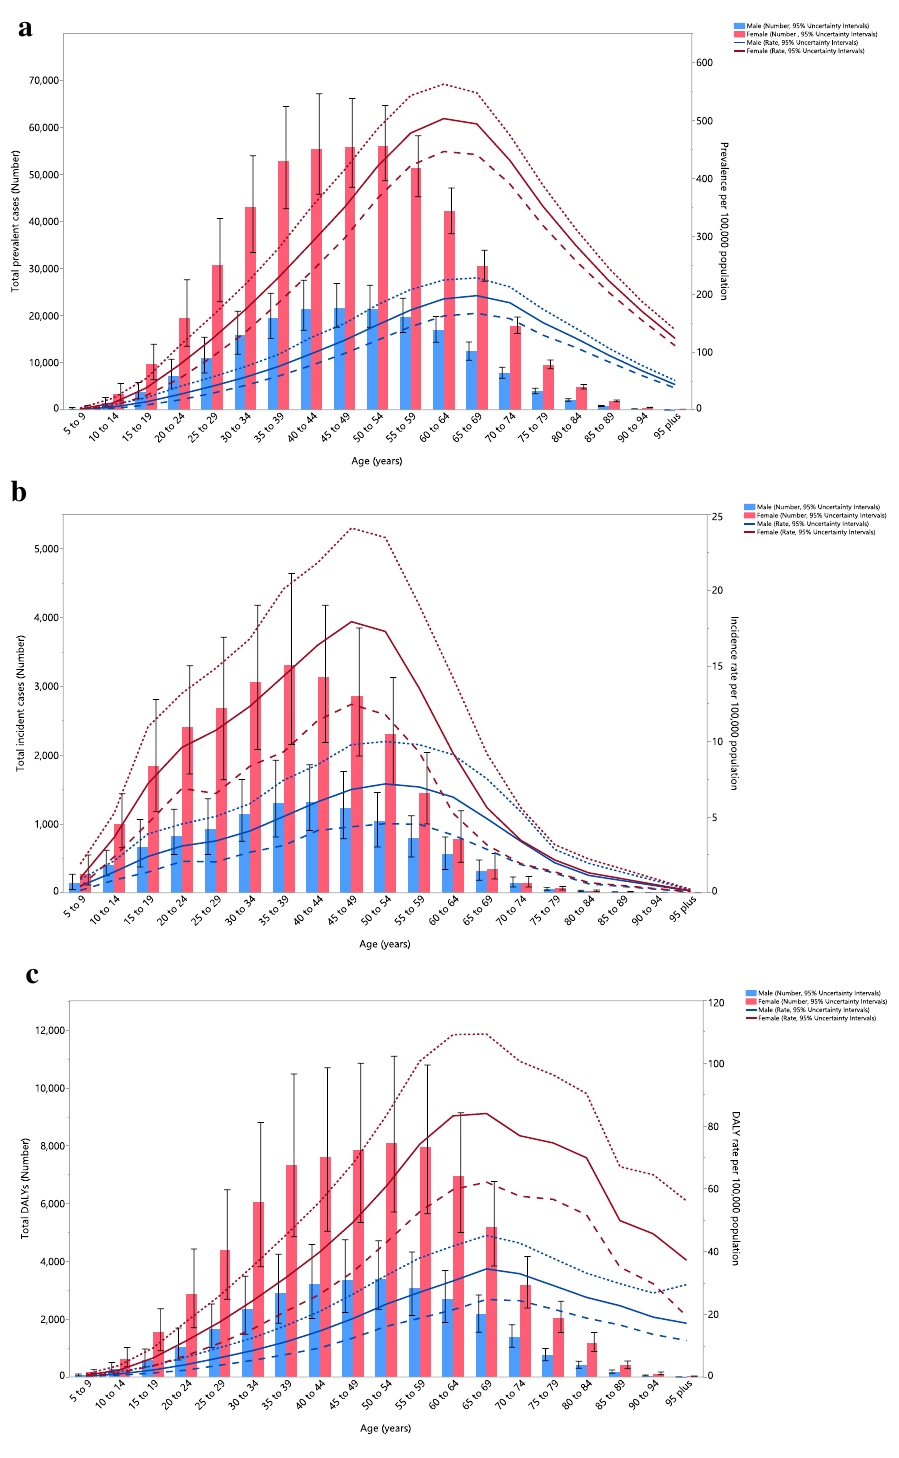
Figure 2. Number of prevalent cases and prevalence ( A ), number of incident cases and incidence rate ( B ), and the number of DALYs and DALY rate ( C ) for rheumatoid arthritis (per 100,000 population) in the Middle East and North Africa region, by age and sex in 2019; Dotted and dashed lines indicate 95% upper and lower uncertainty intervals, respectively. DALY disability-adjusted-life-years. (Generated from data available from http:// ghdx. healt hdata. org/ gbd- resul ts-